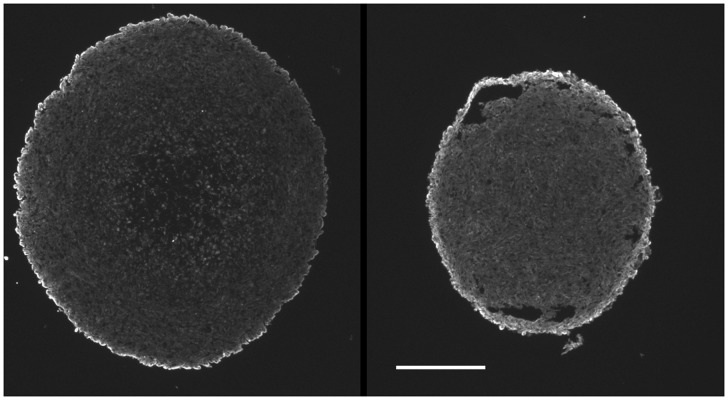
MRC5 fibroblasts form a surface capsule in MC spheroids.In 10-day mixed cell spheroids, vimentin positive fibroblasts migrated to form a surface capsule (left U87+MRC5; right Panc1+MRC5—scale bar 0.25 mm). No surface vimentin staining was observed for spheroids consisting solely of either tumor cell type (data not shown).